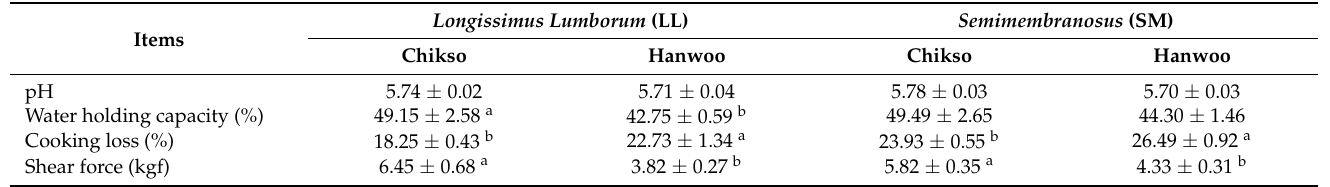
Table 1. Technological quality traits of LL and SM muscles from Chikso and Hanwoo under identical rearing